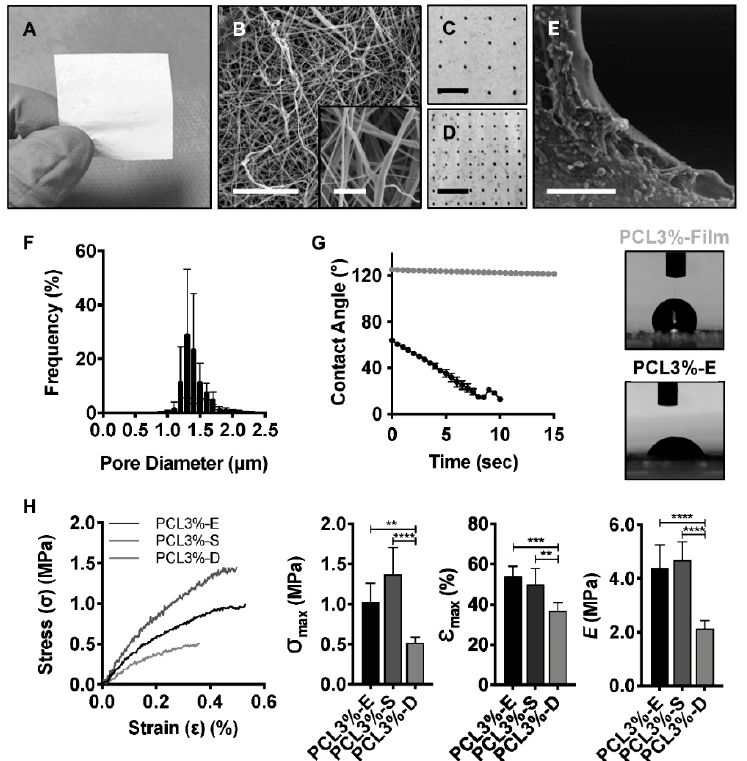
Figure 2. PCL3%-E characterisation and post-manufacture modification. ( A ) Macro image of PCL3%-E, showing ease of handling. ( B ) SEM images of randomly orientated nanoscale fibres. Scale bars: 25 µ m; insert 2.5 µ m. Macro images of laser cut membranes, ( C ) PCL3%-S, with sparse inter-pore distance (4 mm) and ( D ) PCL3%-D, with dense inter-pore distance (2 mm). Scale bars: 0.5 cm. ( E ) SEM image of laser cut pore edge. Scale bar: 100 µ m. ( F ) PCL3%-E pore size frequency distribution. ( G ) Water contact angle measurements and image of pore-free cast films and PCL3%-E. ( H ) Stress-strain curves for electrospun membranes and ultimate stress, strain at break, and elastic modulus reported for each experimental group (from left to right). One-way ANOVA with Tukey’s multiple comparisons post hoc test, ** p < 0.005 *** p < 0.0005 **** p < 0.0001.